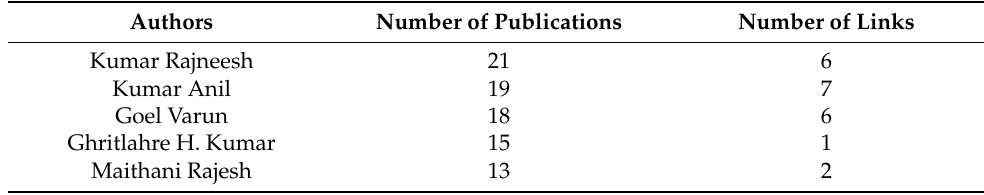
Table 3. Solar air heaters authors ’ bibliometric network details.